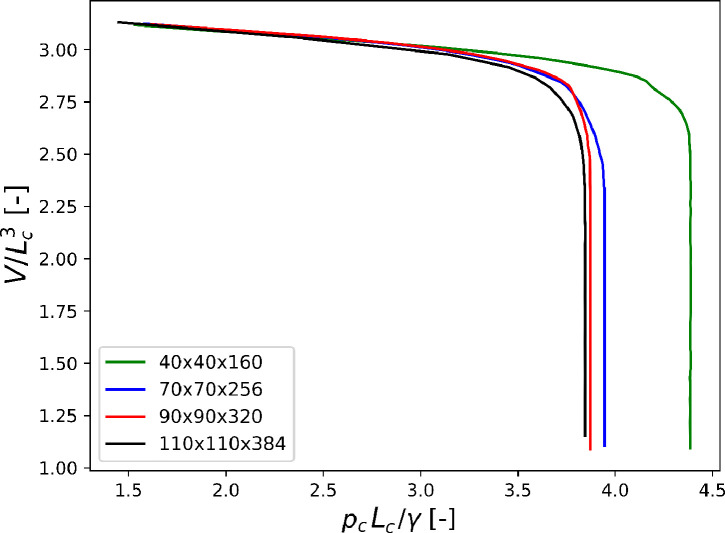
Primary drainage of square-shaped capillary tubes with different discretizations.